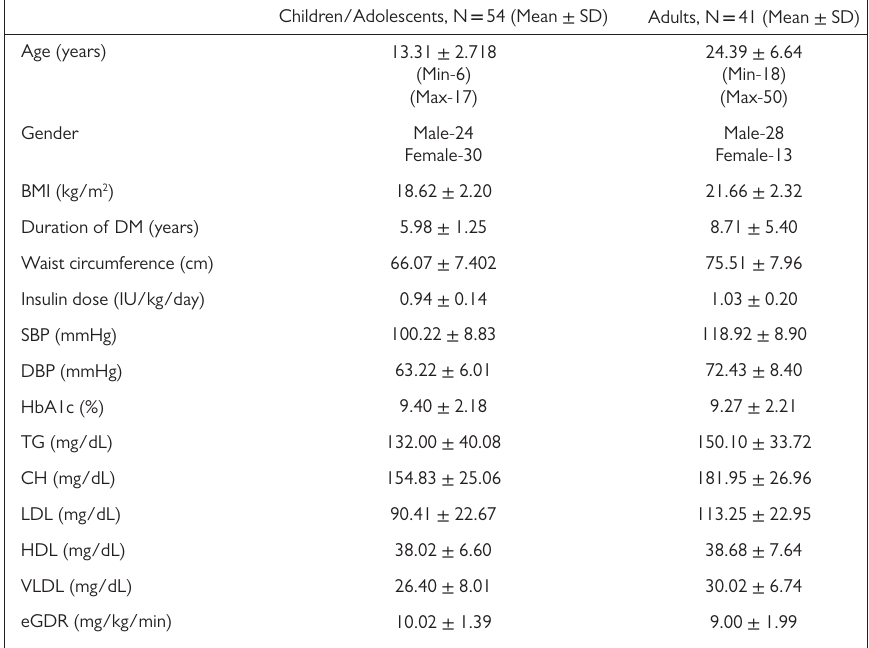
Table 1. Various Characteristics of Children/Adolescents and